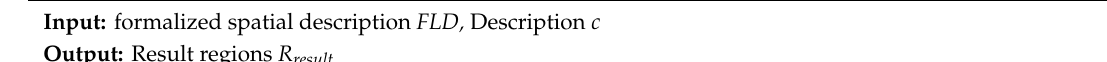
Algorithm 5: The FLDInference algorithm